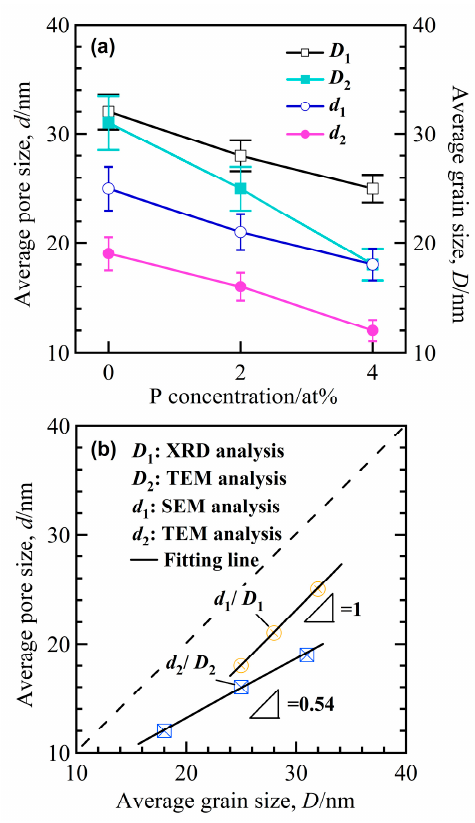
Figure 7. The change dependency of grain size, D ( D 1 from XRD analysis; D 2 from TEM analysis), and pore size, d ( d 1 from SEM analysis; d 2 from TEM analysis), on the P concentration ( a ) and the linear dependency of d 1 / D 1 and d 2 / D 2 ( b ).